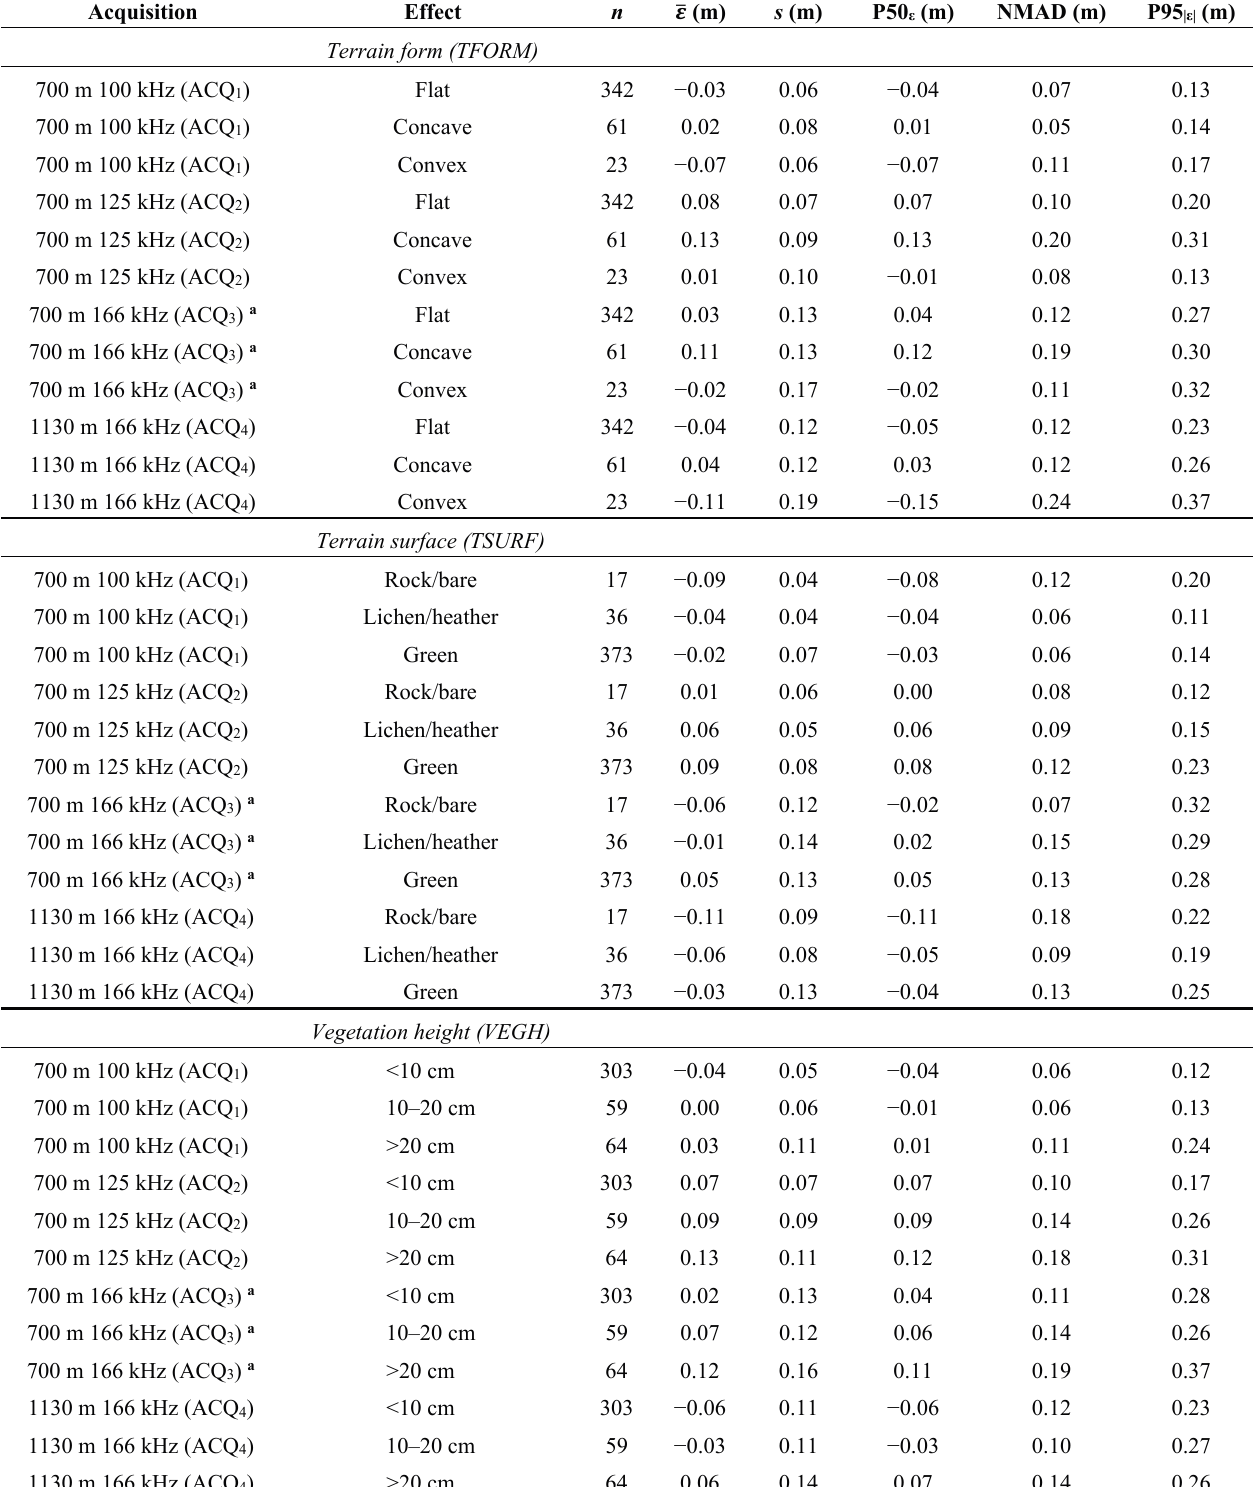
Table 4. Mean error of TIN surface elevation ( (cid:2013)̅ ), standard deviation of the errors ( s ), 50% quantile of the errors (P50 ε ), normalized median absolute deviation (NMAD), and 95% quantile of the absolute value of the errors (P95 | ε | ) for different effects (terrain form, terrain surface, vegetation